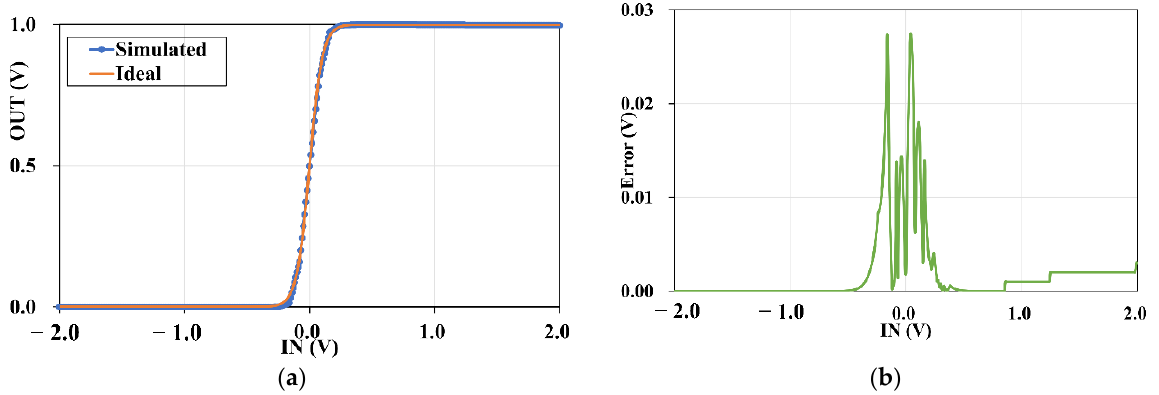
Figure 7. ( a ) The fitting function is based on numerous simulated data points exported from the implementation circuit of the sigmoid and fitted with MATLAB ( W of M4 is 10 ). The orange curve represents the fitting sigmoid, and the blue one is the simulated data. ( b ) Error between the fitting expression and the simulated data.